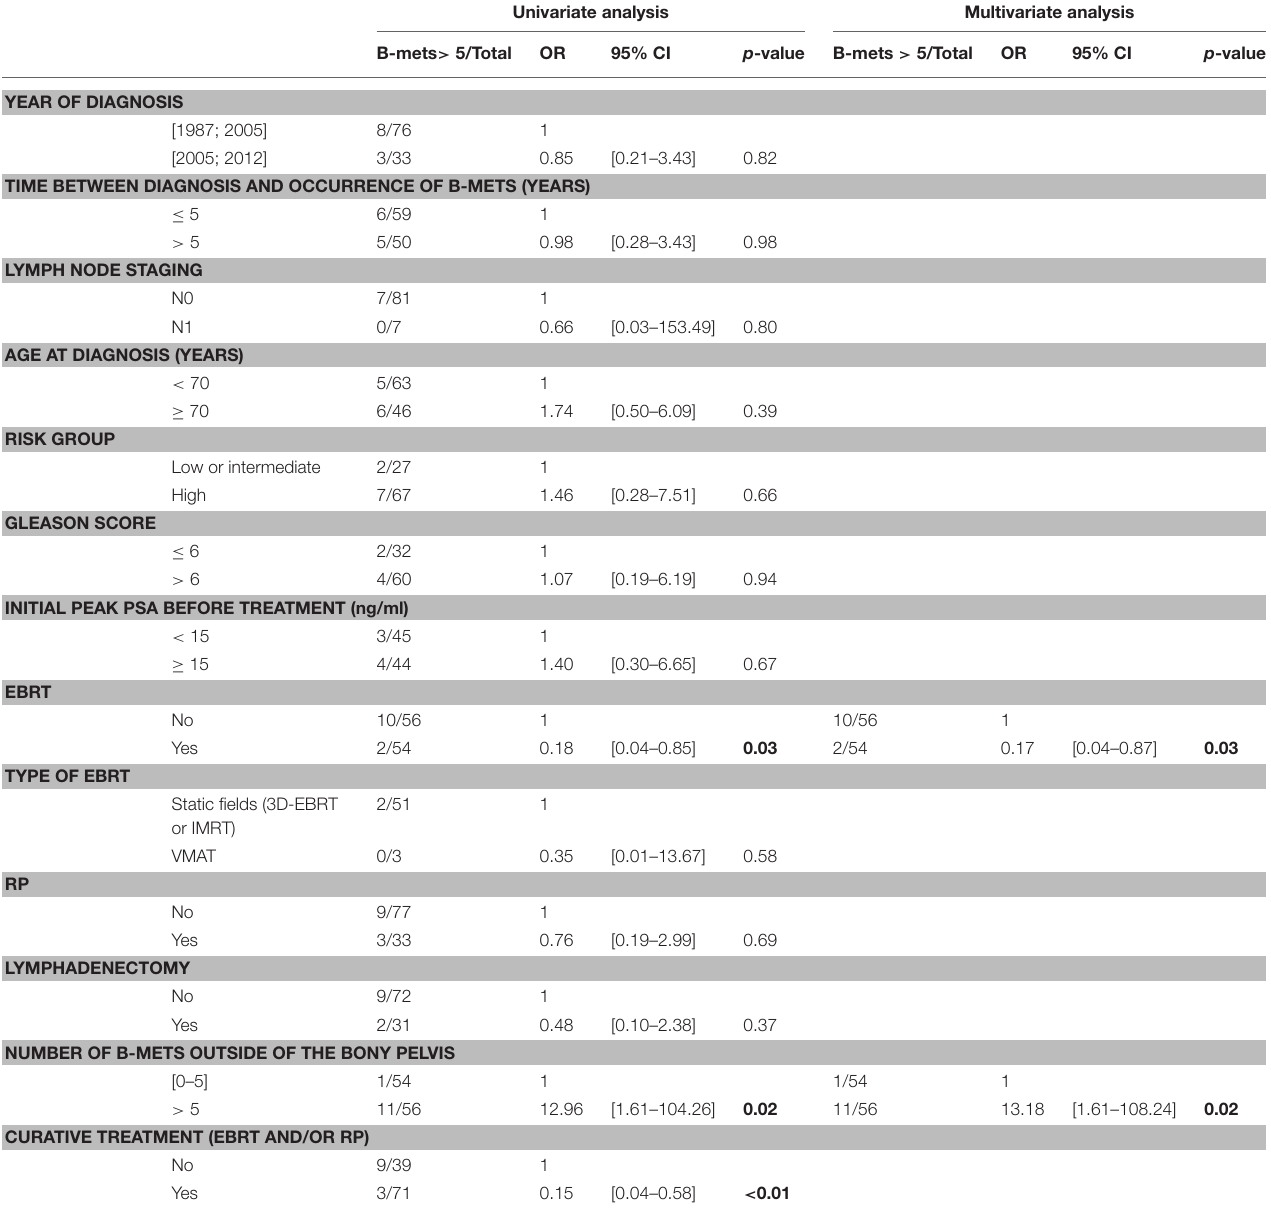
TABLE 3 | Univariate and multivariate analyses of the factors associated with the occurrence of > 5 bone metastases in the bony